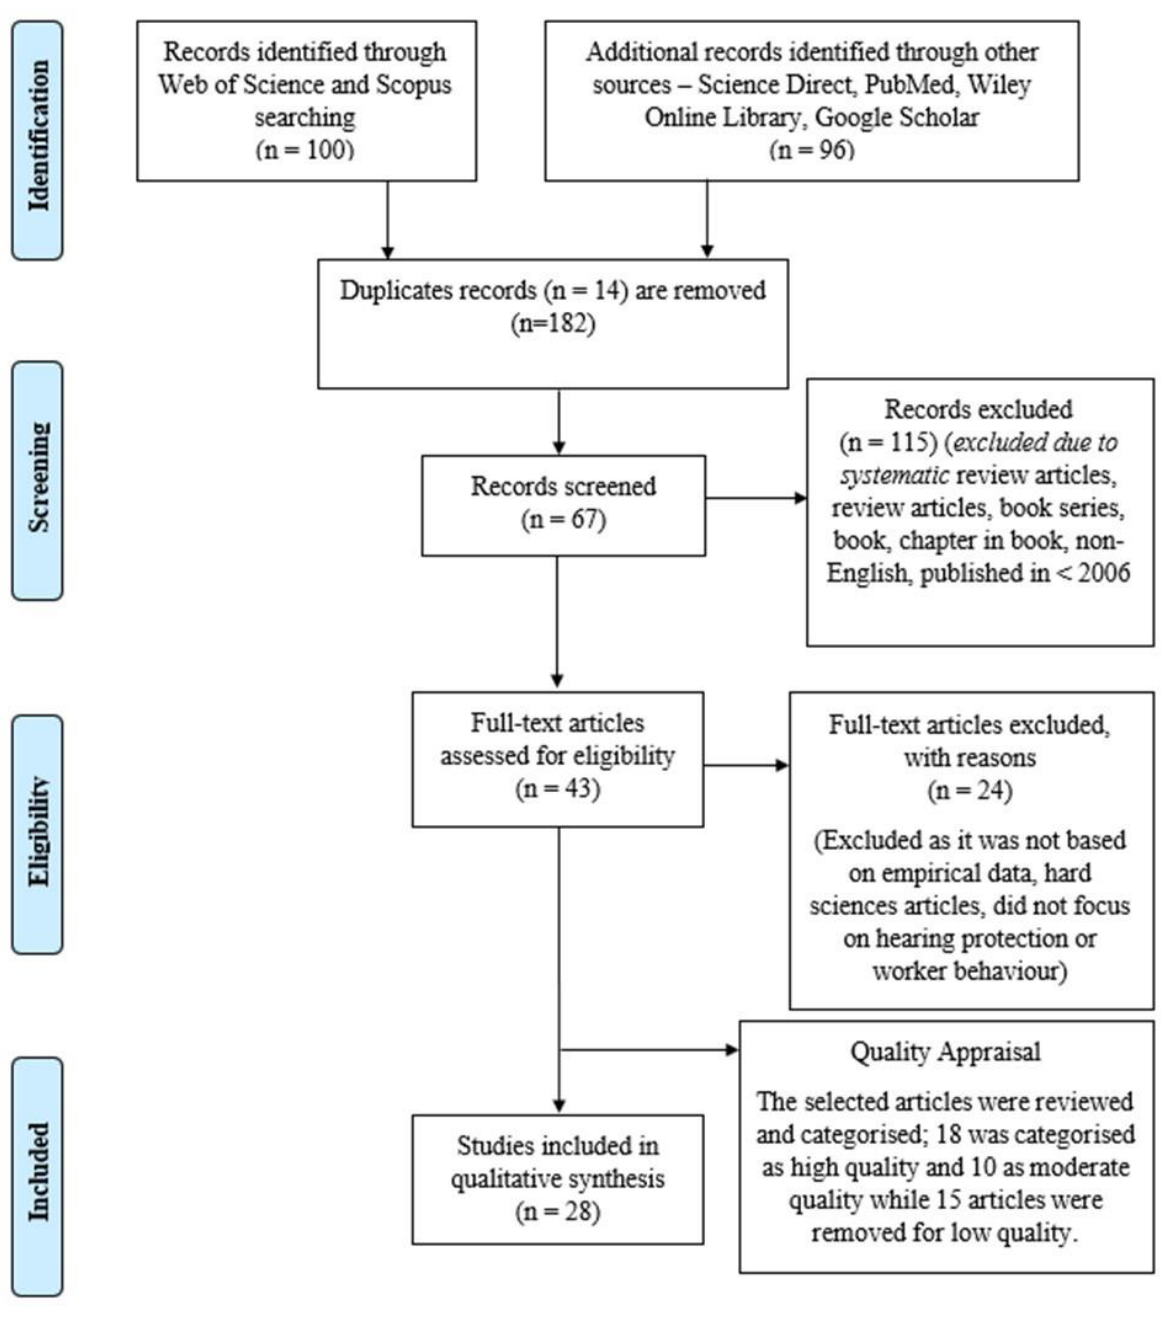
Figure 1. Flow diagram of the study [20,21].